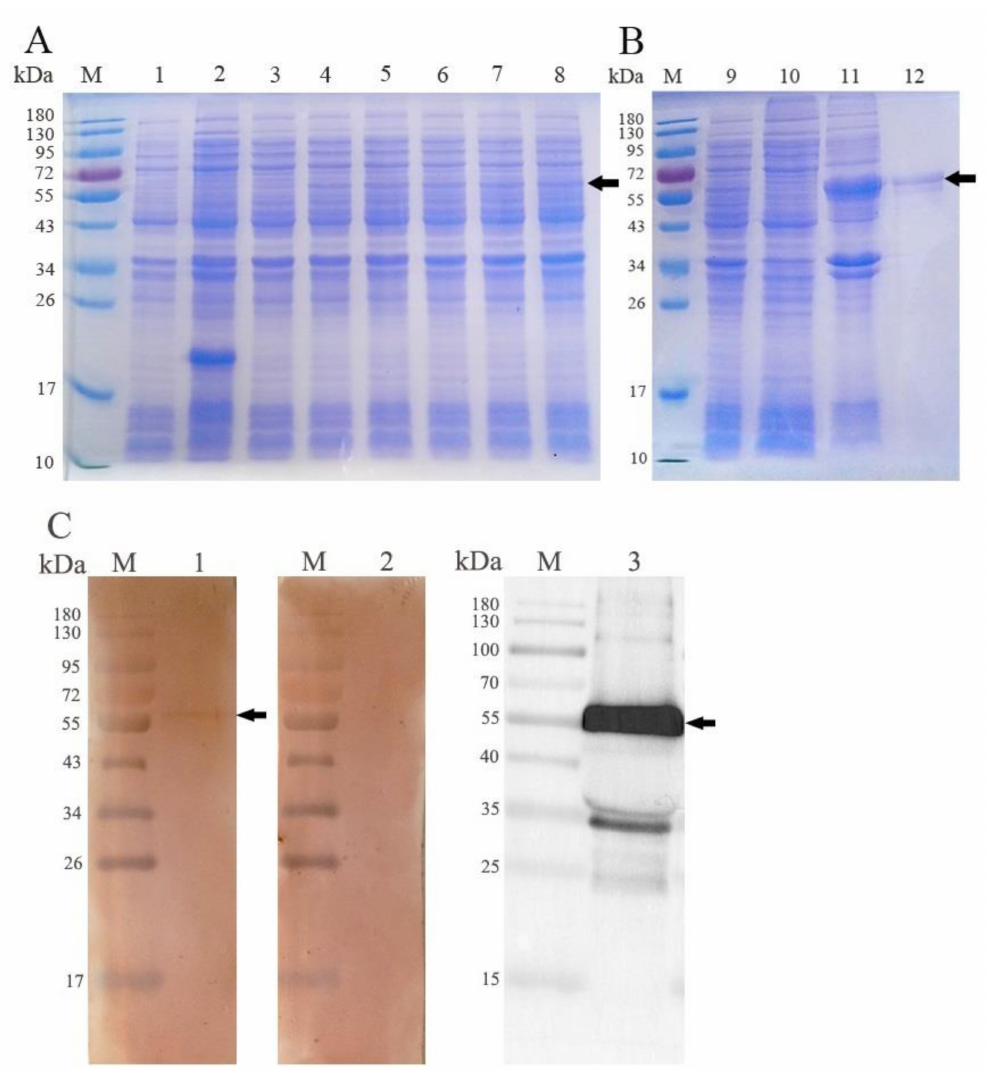
Figure 2. Expression of rEmROM5 and Western blot analysis. ( A ) Induction of rEmROM5 (53.64 kDa) by IPTG for 1–5 h. M, protein standard molecular weight. Lane 1, pET-32a-transfected bacteria before the induction of IPTG. Lane 2, pET-32a-transfected bacteria induced by IPTG for 5 h. Lane 3,